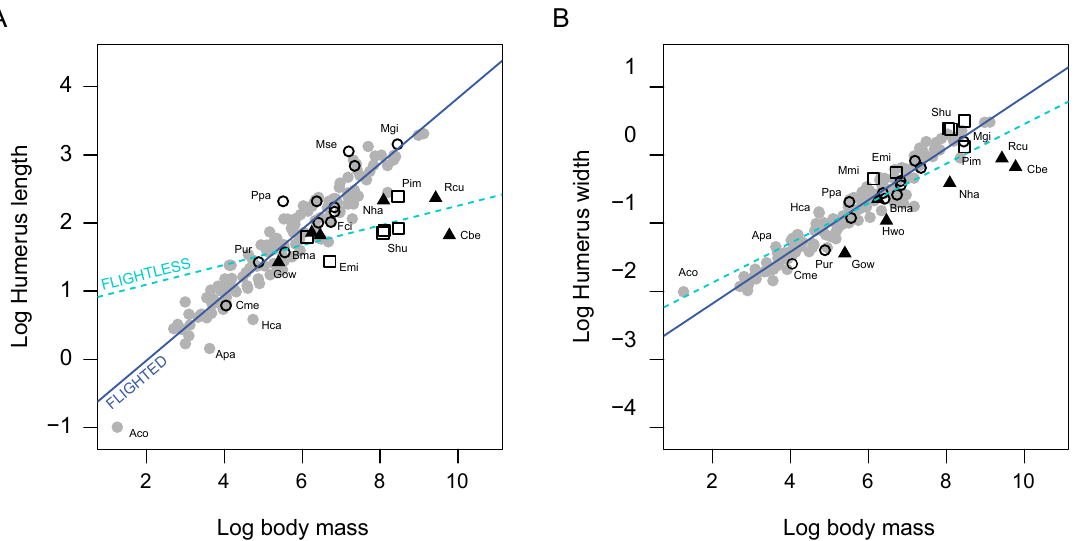
Figure 4. Scaling of classic linear measurements of the humerus, length ( A ) and width at midshaft ( B ) on body mass. Symbols’ shape corresponds with the function of wings given in Figure 2.